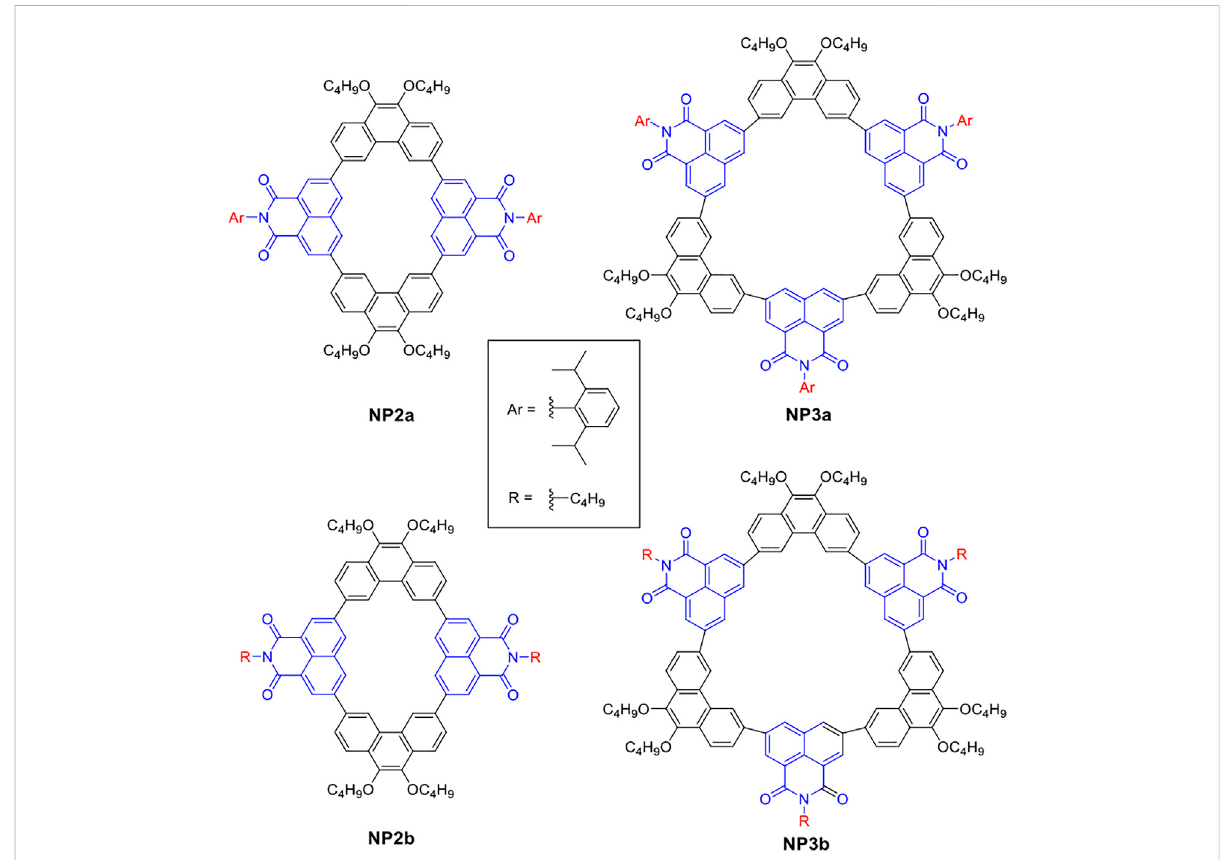
FIGURE 1 Four conjugated macrocycles based on phenanthrene (Phen) and 1, 8-naphthalimide